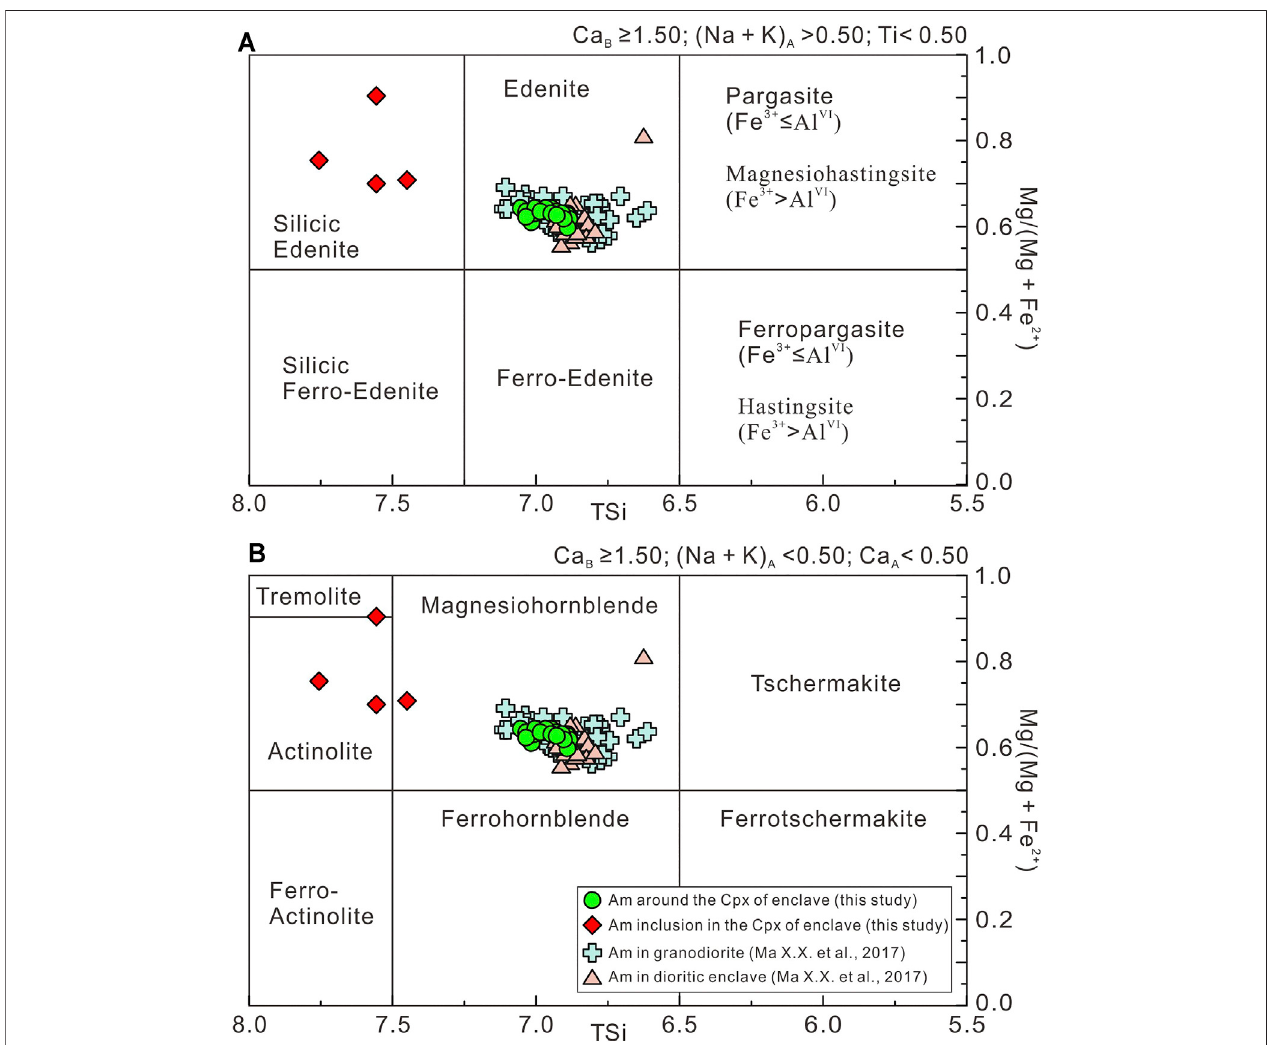
FIGURE 11 | Classi fi cation of the amphibole in the present study. (A,B) Two diagrams showing the classi fi cation of amphiboles according to the nomenclature of Leake et al. (1997).